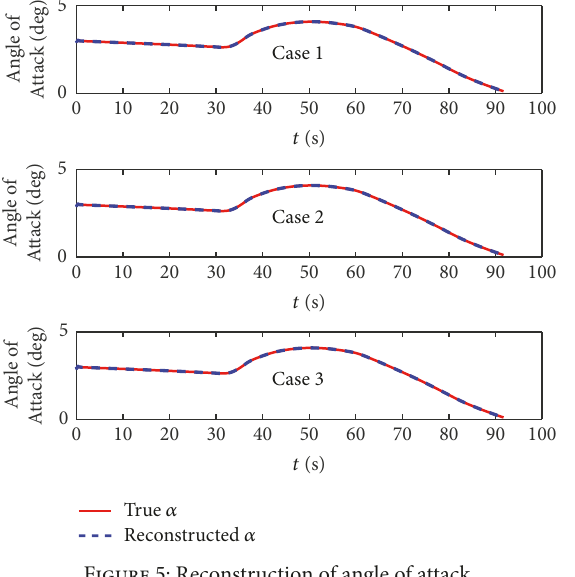
Figure 5: Reconstruction of angle of attack.